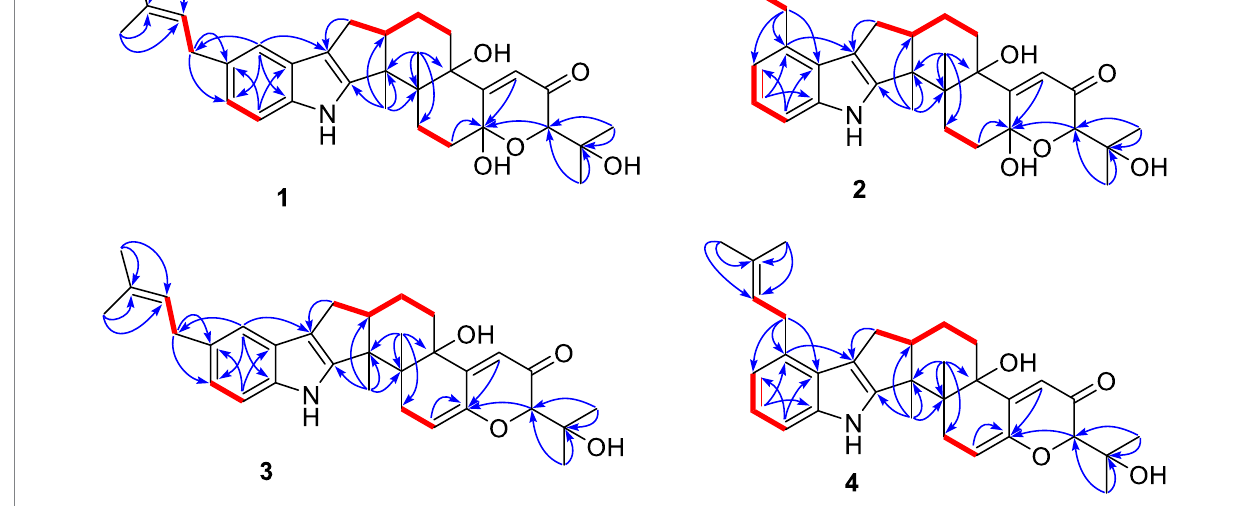
FIGURE 2 Selected HMBC and COSY correlations of compounds 1 - 4 .